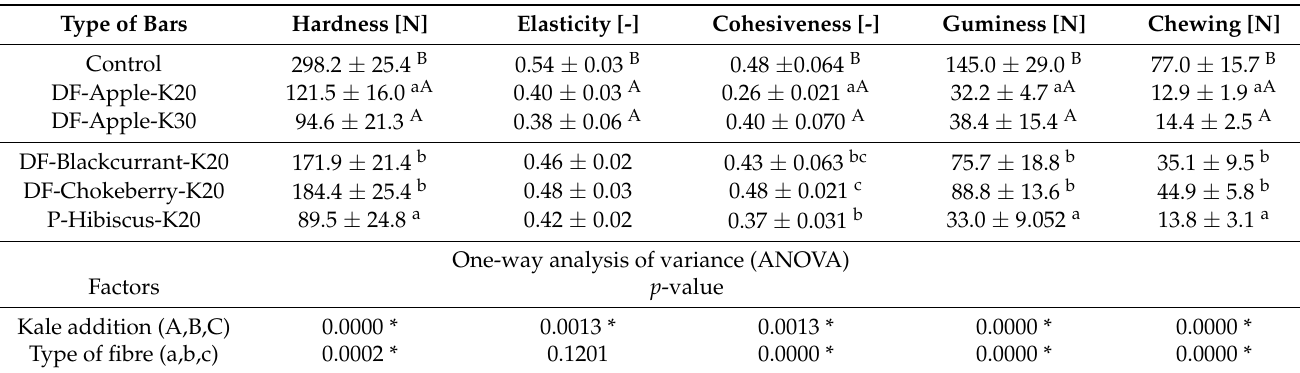
Table 3. The effect of kale and fibre preparation on the texture profile of multigrain bars. The bar codes are explained in Table